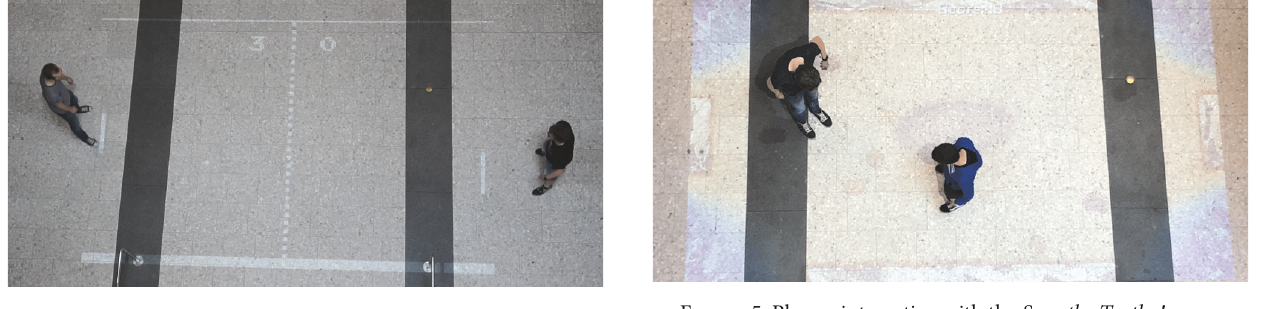
Figure 4: Players interacting with the Pong game (the two dark stripes are, unfortunately, part of the floor decoration).